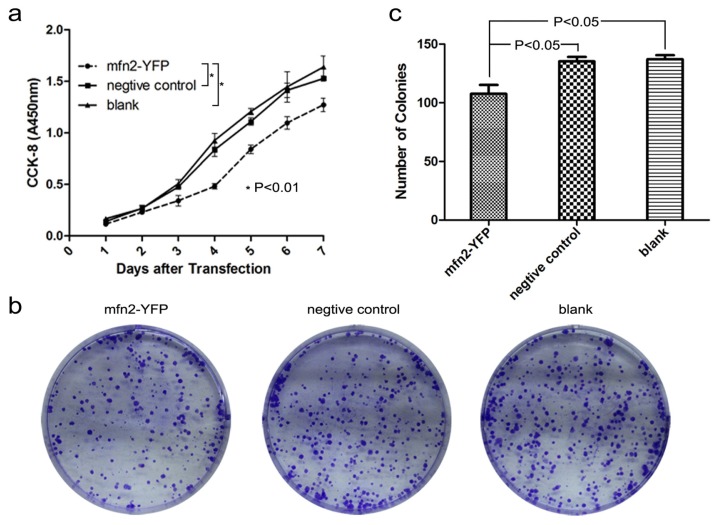
Mfn2 significantly suppressed gastric cancer cell proliferation. (a) The result of CCK-8 cell proliferation assay (detection: 450 nm, reference: 630 nm) showed the absorbance to be significantly lower in the Mfn2-YFP group compared to the other two groups (p < 0.01); (b,c) Colony-forming assay: The colony formation was significantly lower in the Mfn2-YFP group compared to the other two groups (p < 0.05). There was no difference between the negative control and blank (p > 0.05).